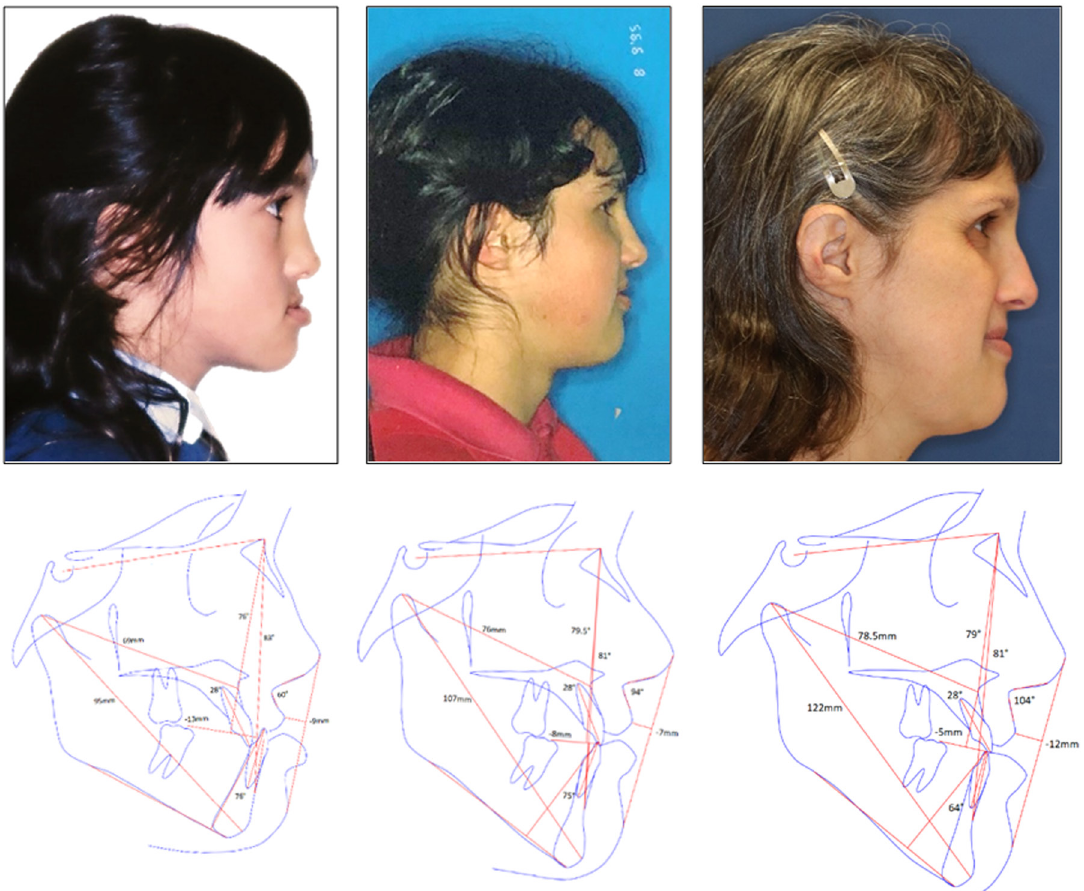
Figure 7. Profile view of Pre-tx (1991), Post FM treatment (1996) and 24 years post FM Treatment